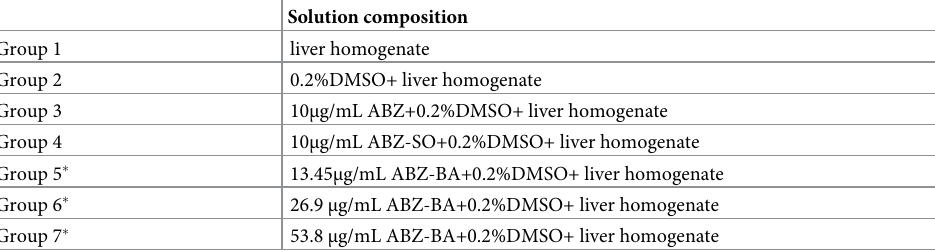
Table 1. Grouping of ABZ-BA and PSC in vitro co-culture and composition of culture